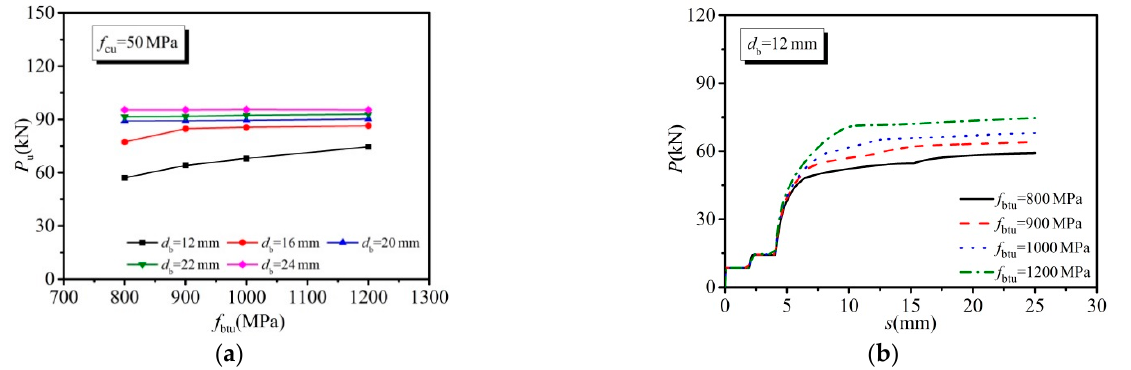
Figure 12. Effect of bolt tensile strength: ( a ) shear bearing capacity; ( b ) load–slip relationship.